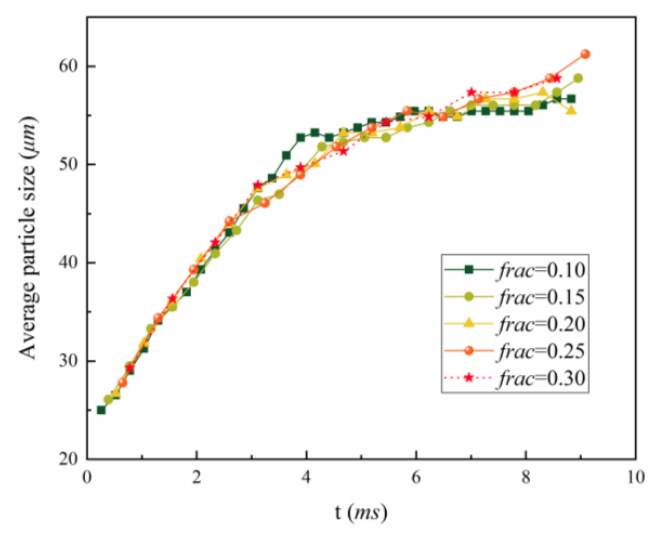
Figure 4. Calculated average particle sizes with different time fraction parameters.